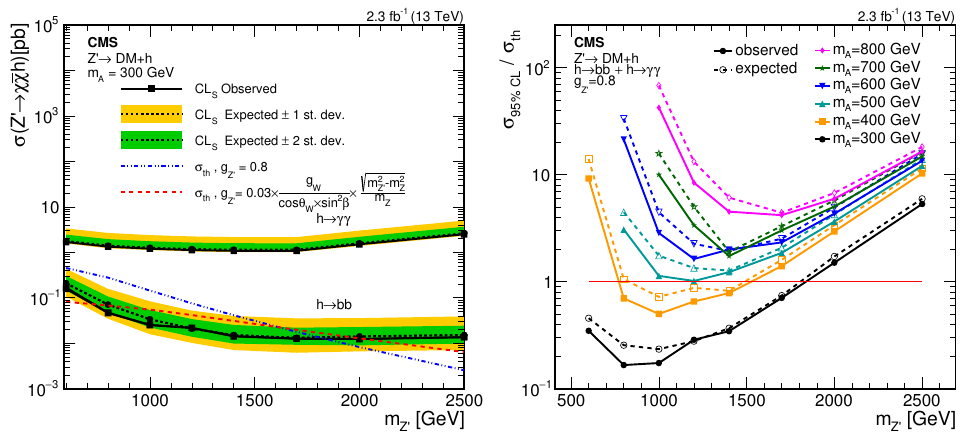
Figure 9 . Left: the expected and observed 95% CL limits on dark matter production cross sections for h ! bb and h ! (cid:13)(cid:13) for m A = 300 GeV. The exclusion region is shown for two g Z 0 values. The dark green and light yellow bands show the 68% and 95% uncertainties on the expected limit. Right: the expected and observed 95% CL limits on the signal strength for m A = 300{800 GeV are shown. Other parameters for this model are (cid:12)xed to m (cid:31) = 100 GeV and tan (cid:12) = g (cid:31) = 1. The theoretical cross section ( (cid:27) th ) used for the right-hand plot is calculated using g Z 0 = 0.8.